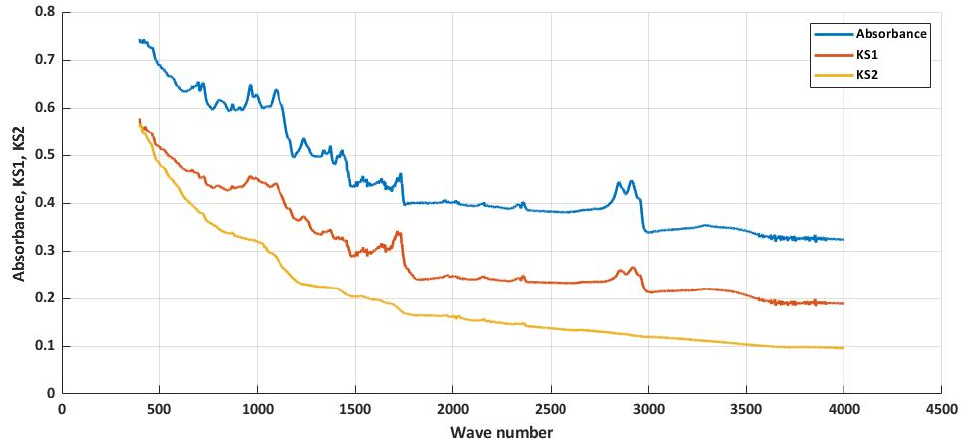
Figure 3. Results for VO_20_PVB_80_TF [authors’ own processing].